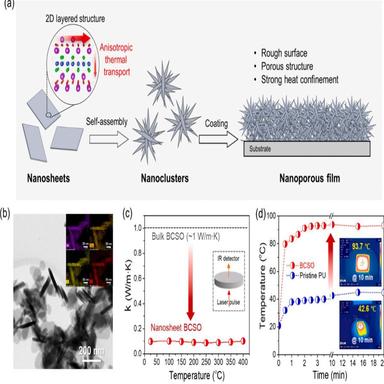
Effects of nanosheets and 2D layered structure on thermal and optical properties of BCSO: (a) Schematic representation of anisotropic thermal transport property of nanosheets (2D layered structure) and nanoporous film formation from nanoclusters, (b) TEM image (Inset shows TEM - elemental mapping), (c) Comparison of thermal conductivities of bulk and nanosheet, and (d) Changes in surface temperature with illumination time under dry state. (Inset shows the IR images of the nanoporous film under 1 sun illumin